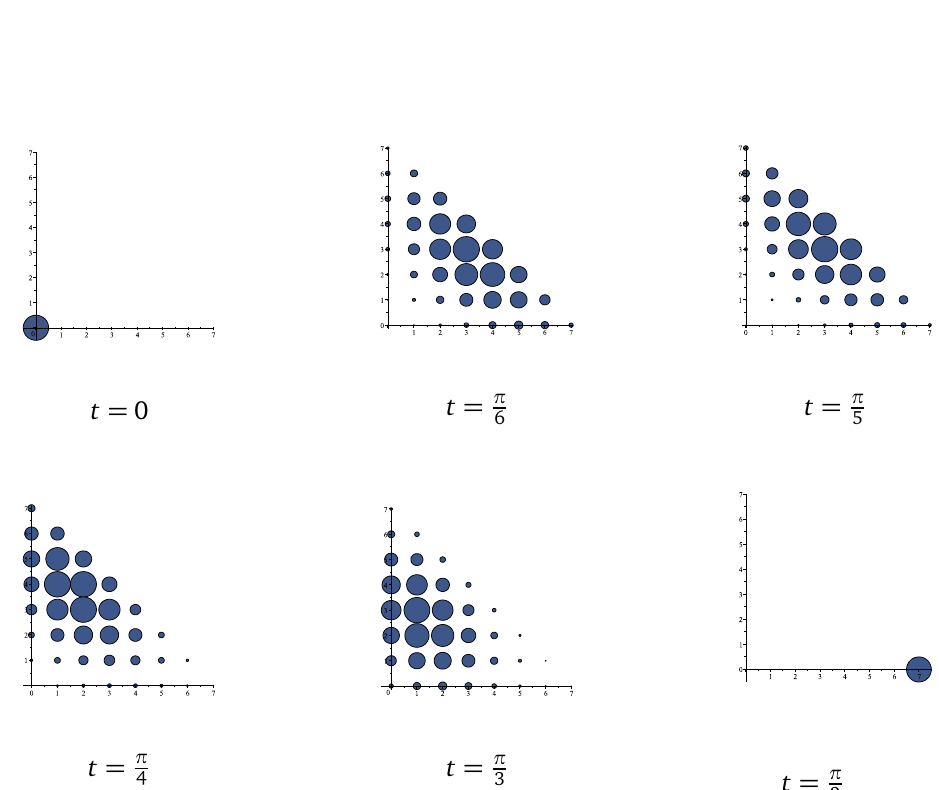
( t ) | for 2 A + A ( 1,0 ) ( 0,1 ) when N i , j ( t ) | at the given lattice point ( i , j ) . PST occurs i , j )